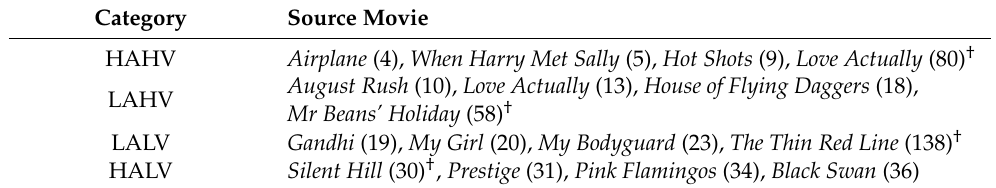
Table 1. The source movies of the videos used are listed per quadrant in the valence–arousal space. Video IDs are stated in parentheses, sources marked with a † were taken from the MAHNOB- HCI dataset [55]; all the others stem from DECAF [54]. In the category column, H, L, A, and V stand for high, low, arousal, and valence, respectively. This table has been adapted from Miranda-Correa et al.